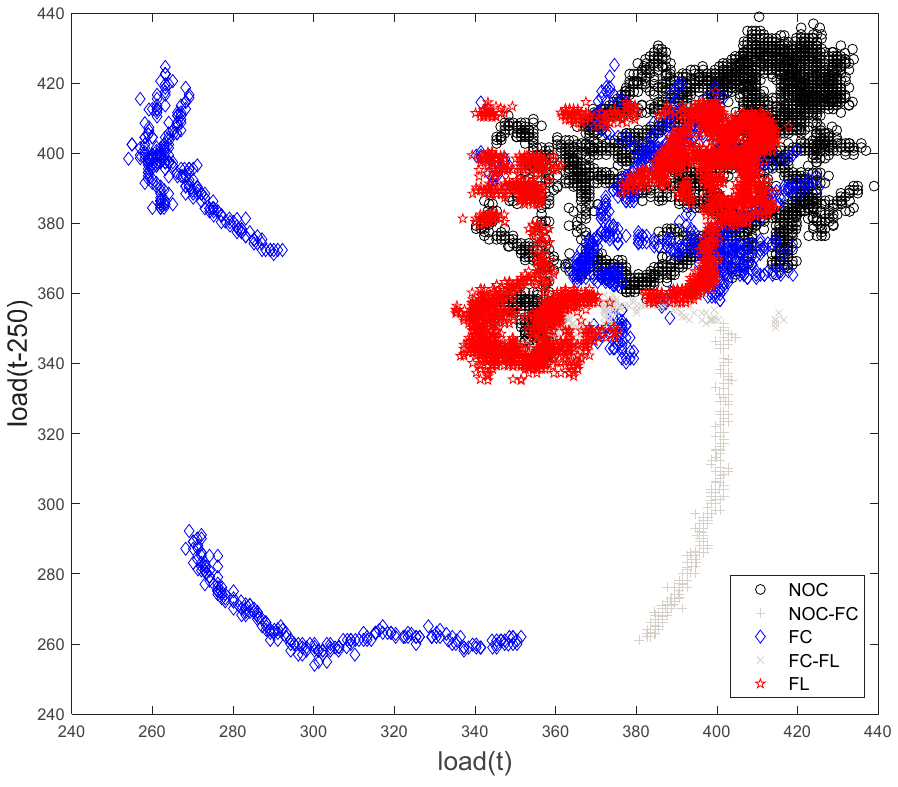
Figure 15. Visualization of the LTM feature set of the mill load data (Case Study 1), showing the NOC, FC, and FL control states. The scores indicated by ‘NOC–FC’ and ‘FC–FL’ show transitions between the NOC and FC and FC and FL states, respectively.